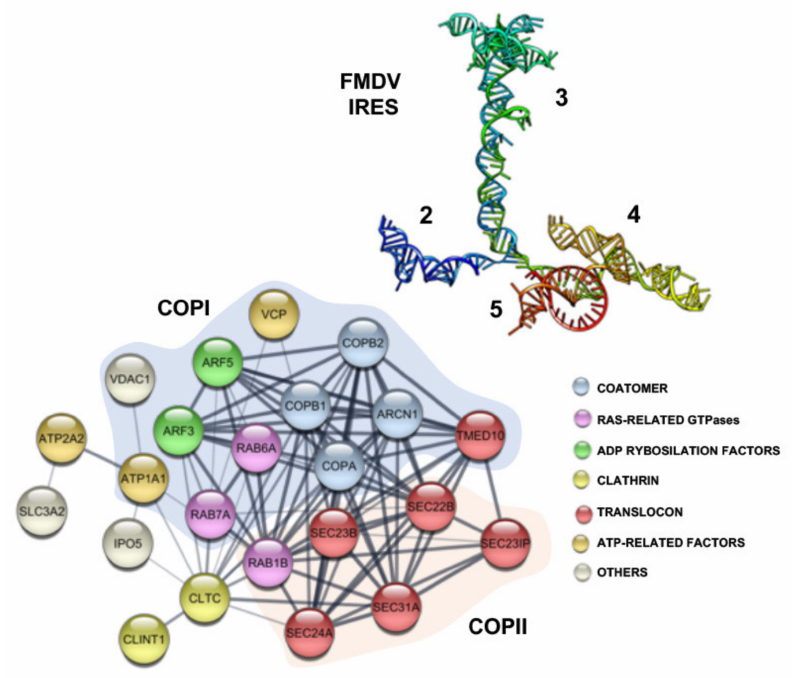
Figure 4. Host factors interacting with domain 3 of the FMDV IRES element. RNA structure model of the IRES element based on RNA Selective 2 (cid:48) Hydroxyl Acylation analyzed by Primer Extension (SHAPE) probing (33) (top). The central domain (3) is colored in green. The functional association of proteins identified using the tRNA-scaffold methodology (123), interacting with domain 3 of the IRES, related to ER-Golgi vesicles trafficking was generated with STRING software (https://string-db.org). Factors involved in the anterograde (COPII) or retrograde (COPI) transport are marked by orange and blue shadow, respectively. Proteins are represented by circles and colored based on their functional